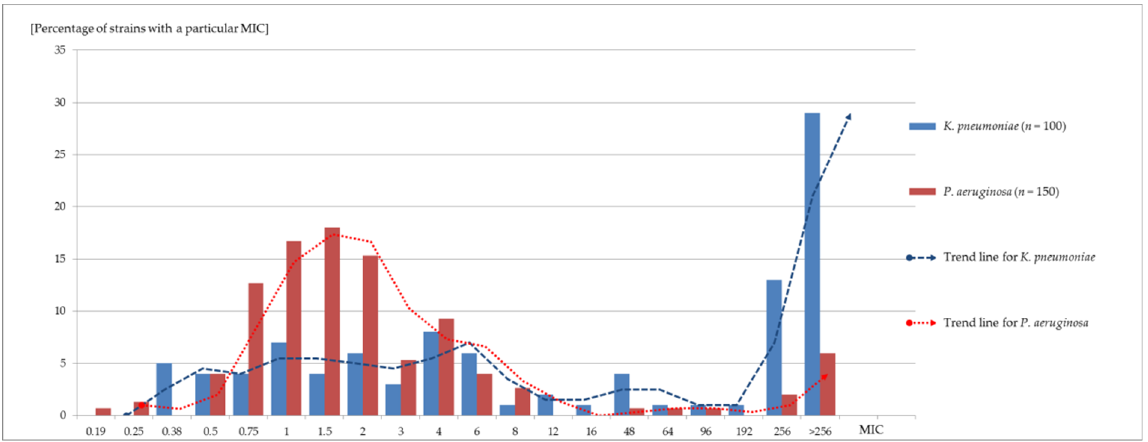
Figure 1. Ceftolozane – tazobactam MIC distribution in the groups of the examined isolates ( n = 250) .